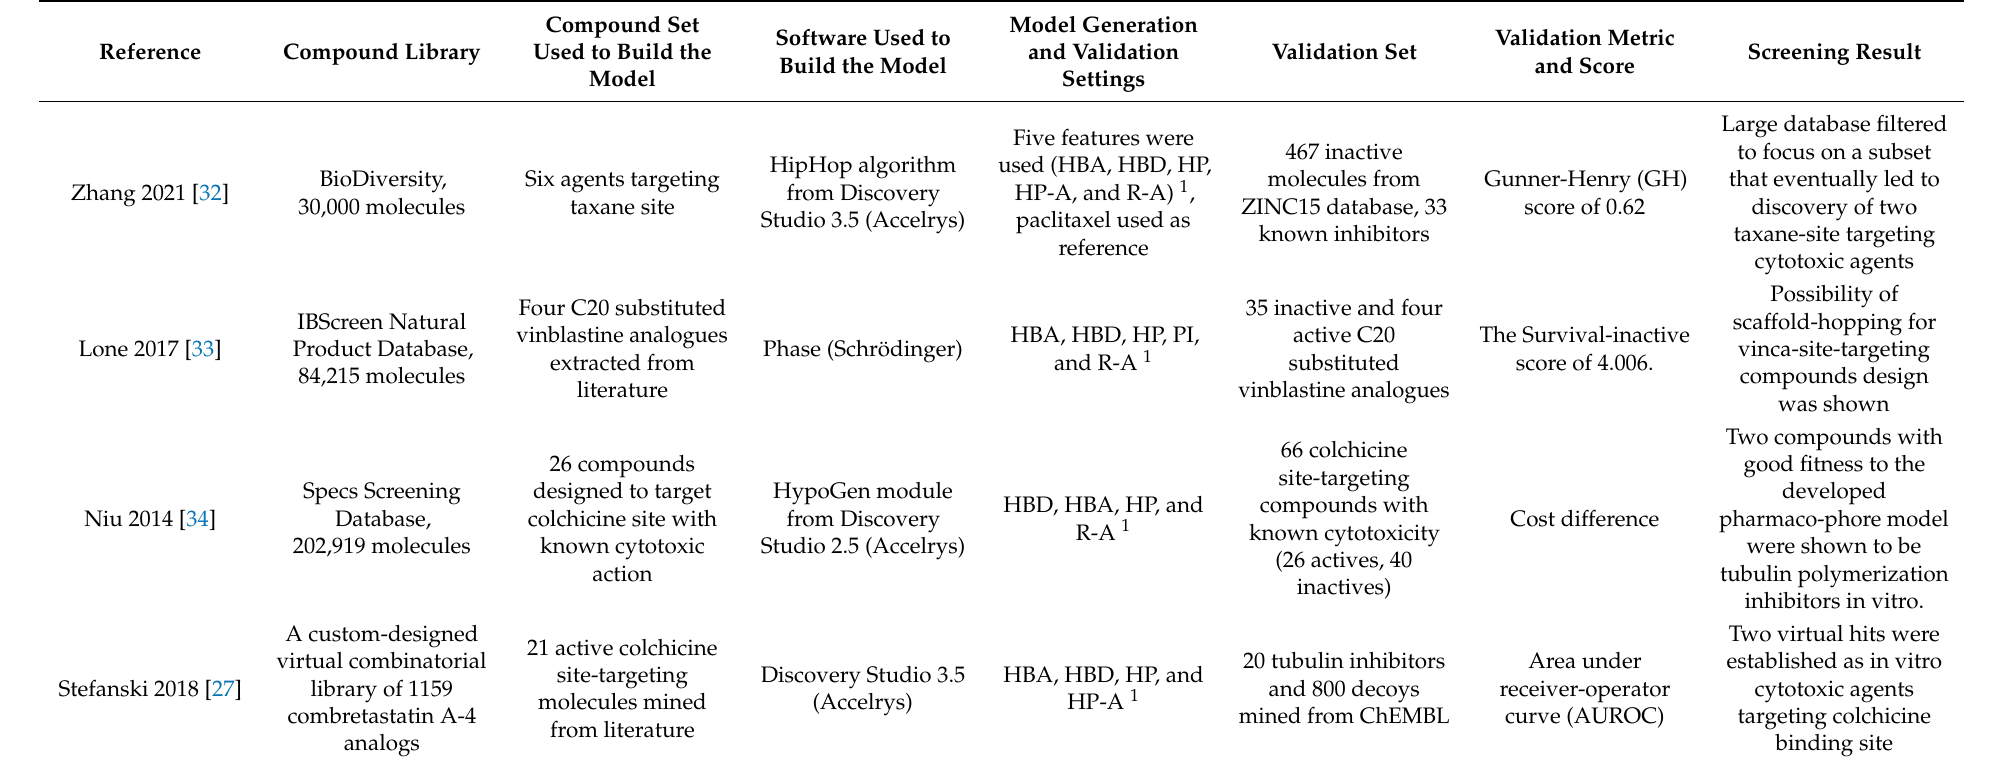
Table A3. Summary of ligand-based pharmacophore screening